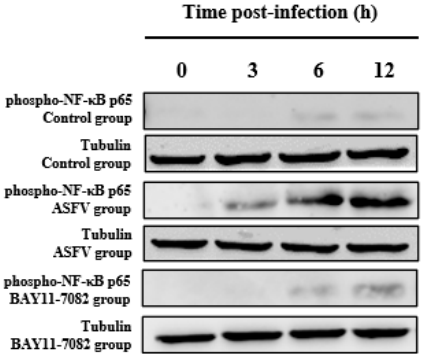
Figure 6. Effect of BAY11-7082 on the phosphor-NF- κ B p65 protein after ASFV infection. Western blotting was used to measure the expression of the phosphor-NF- κ B p65 protein at 0, 3, 6, and 12 h in each group of PAMs. Levels of pp65 increased after ASFV infection; however, this effect was reversed by the NF- κ B inhibitor BAY11-7082. The expression of tubulin was used as a positive con- trol.